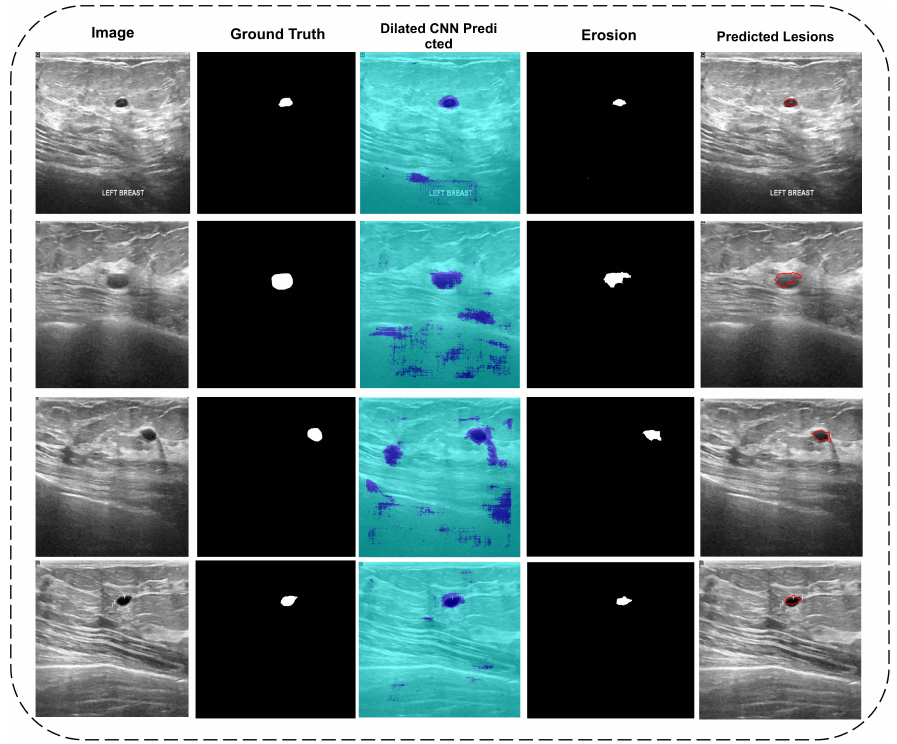
Figure 6. Column 1: Input images; Column 2: Actual mask; Column 3: Di-CNN predicted; Column 4: Erosion operation; Column 5: Real vs. predicted